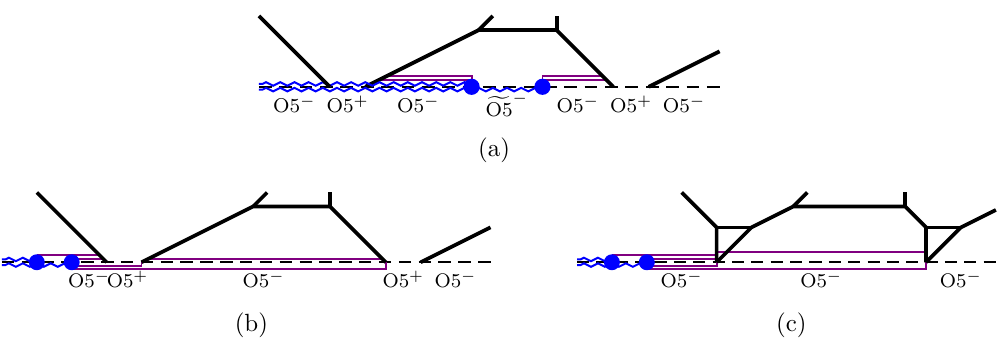
Figure 5. (a) Couple two spinors after Higgsing figure 2(c). (b) Moving two half D7-branes and corresponding monodromy cuts to far left. (c) Applying generalized flop transition to spinors.